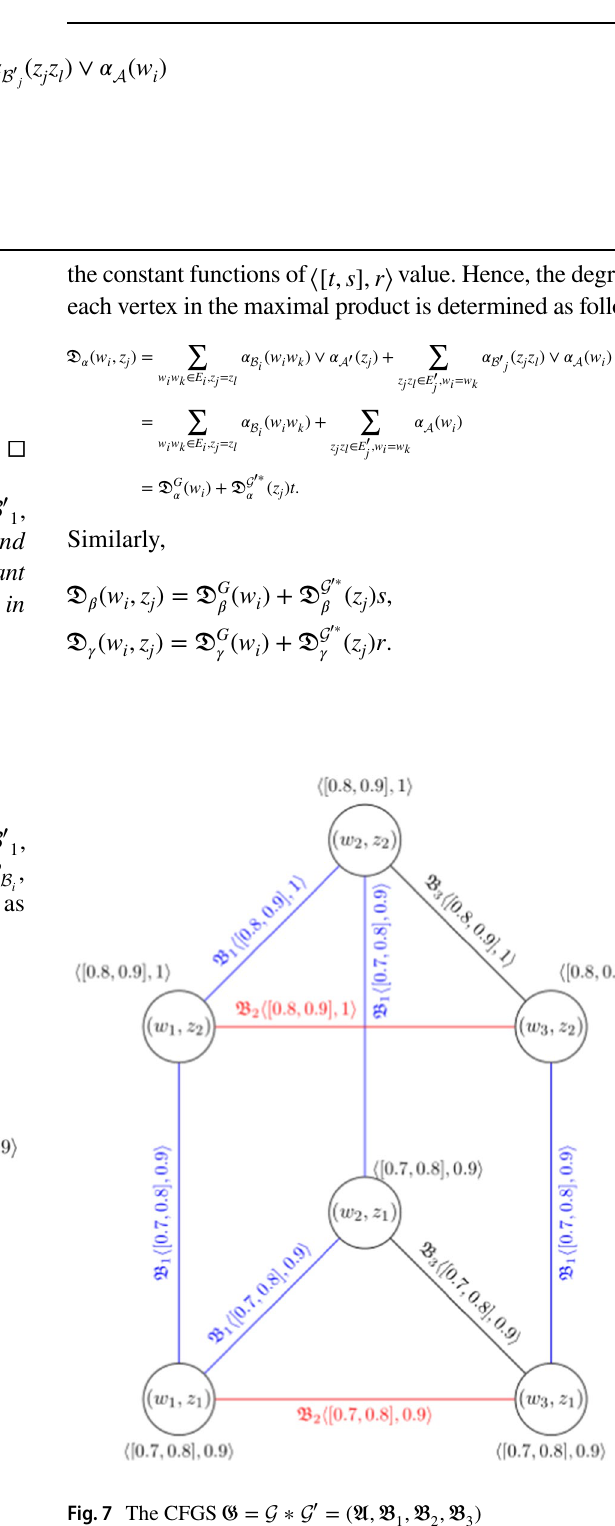
Fig. 6 CFGSs G = ( A , B 1 , B 2 , B 3 ) and G � = ( A � , B � 1 )